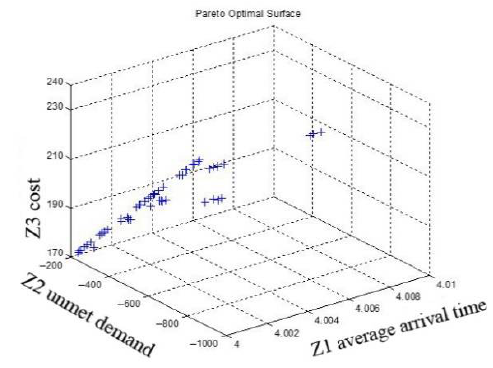
Figure 3. Pareto frontier map. Table 9. Five groups of Pareto optimal solutions of the second stage.